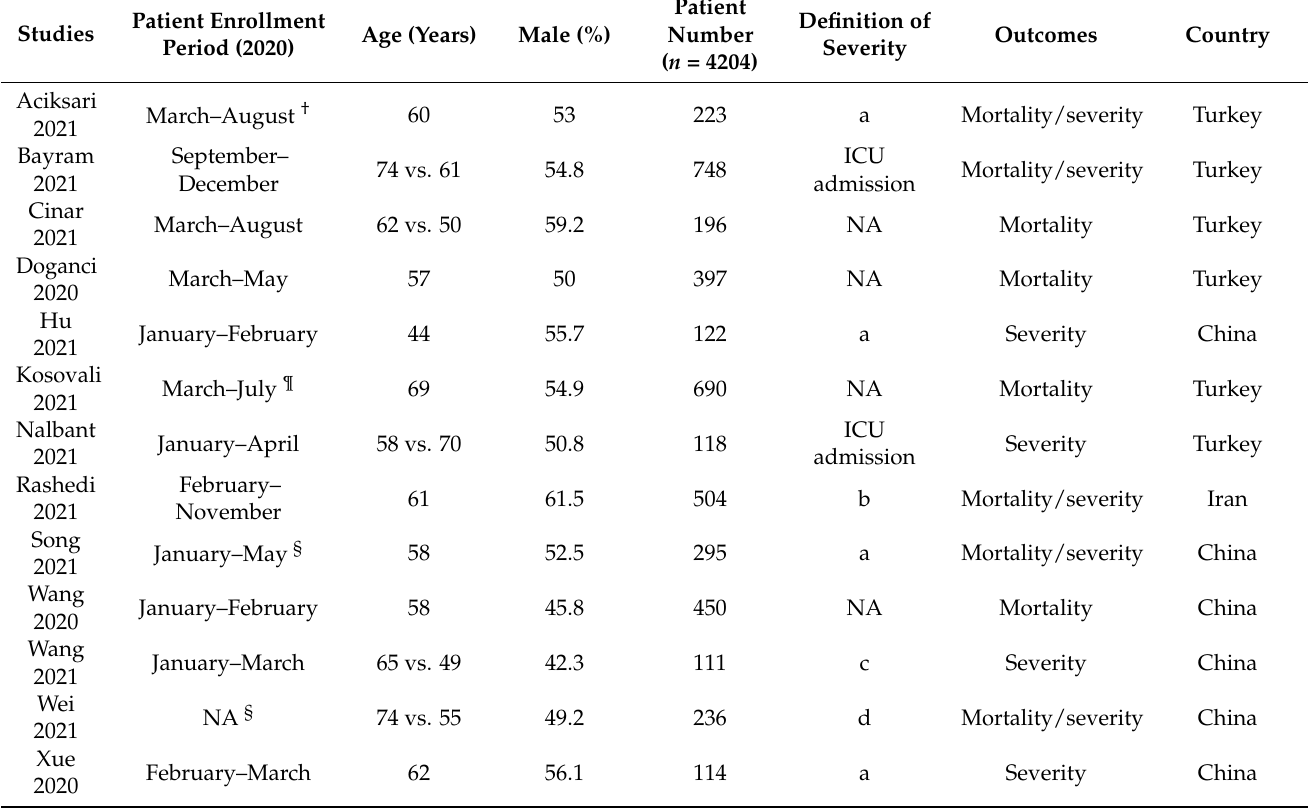
Table 1. Characteristics of studies ( n =